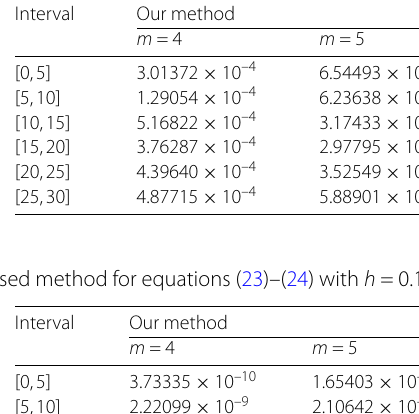
Table 2 Err of the proposed method for equations (23)–(24) with h = 1 Interval Our method m = 4 m = 5